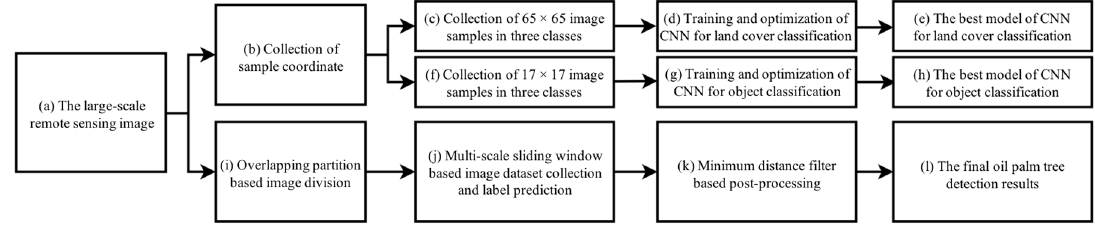
Figure 2. The overall flowchart of the proposed TS-CNN-based method.